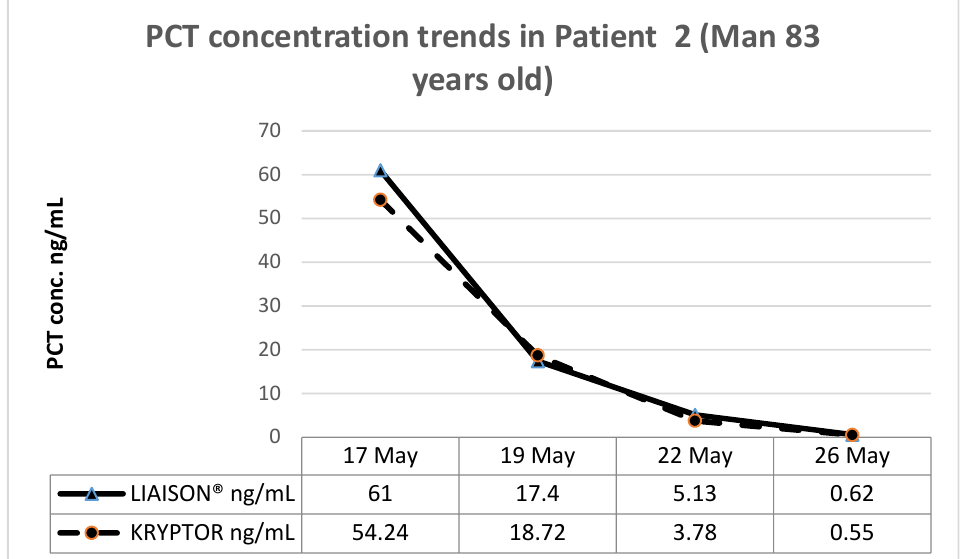
Figure 4. Patient 2 (Long-term hospitalization, man 83 years old).